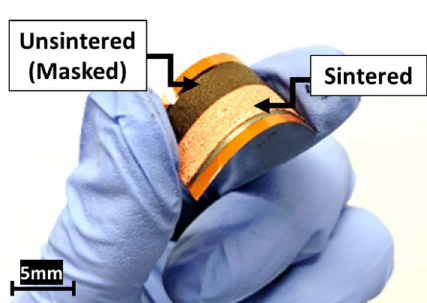
Figure 2. Half-sintered CPN ink flexible electrodes sintered at 2800 V for 3 ms (5.17 J/cm 2 ) for selective electroplating